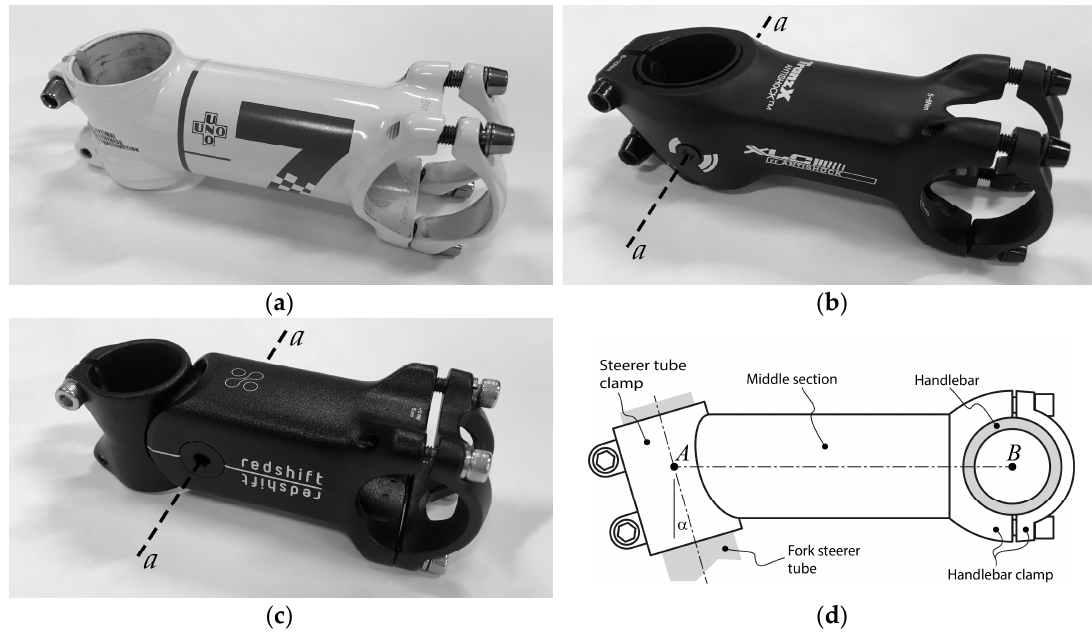
Figure 1. Tested stems: ( a ) Kalloy Uno 7, ( b ) TranzX ANTISHOCK, ( c ) Redshift ShockStop, and ( d ) diagram showing the relevant parts of the